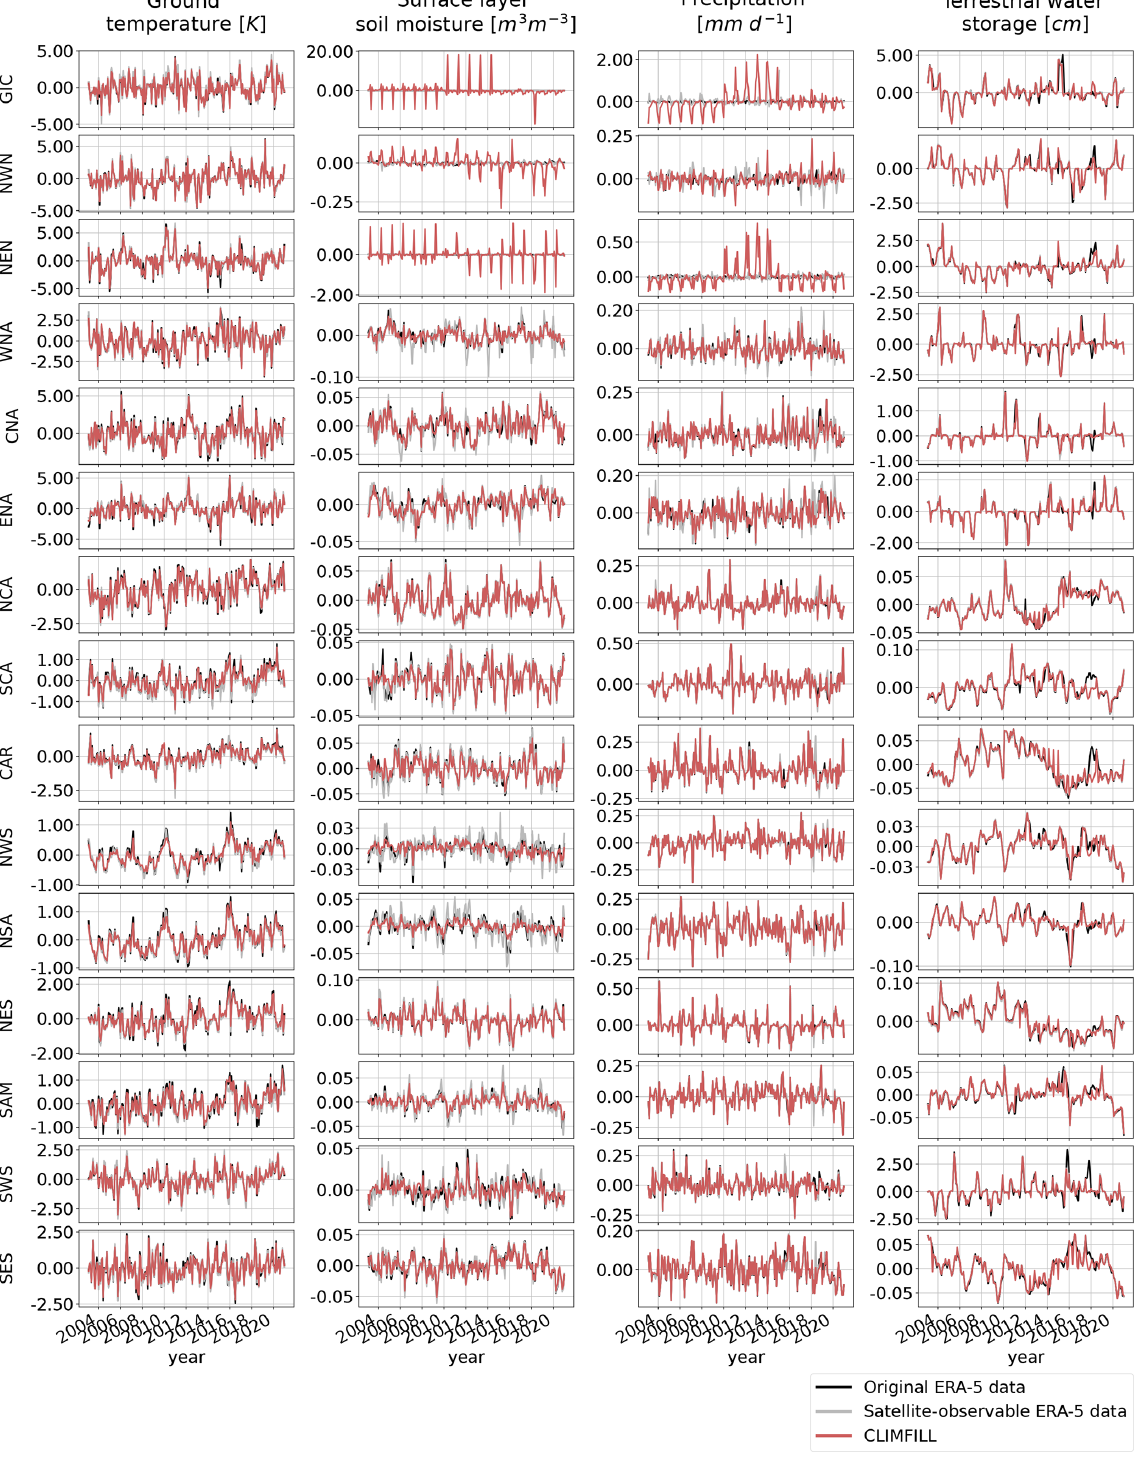
Geosci. Model Dev., 15, 4569–4596, 2022